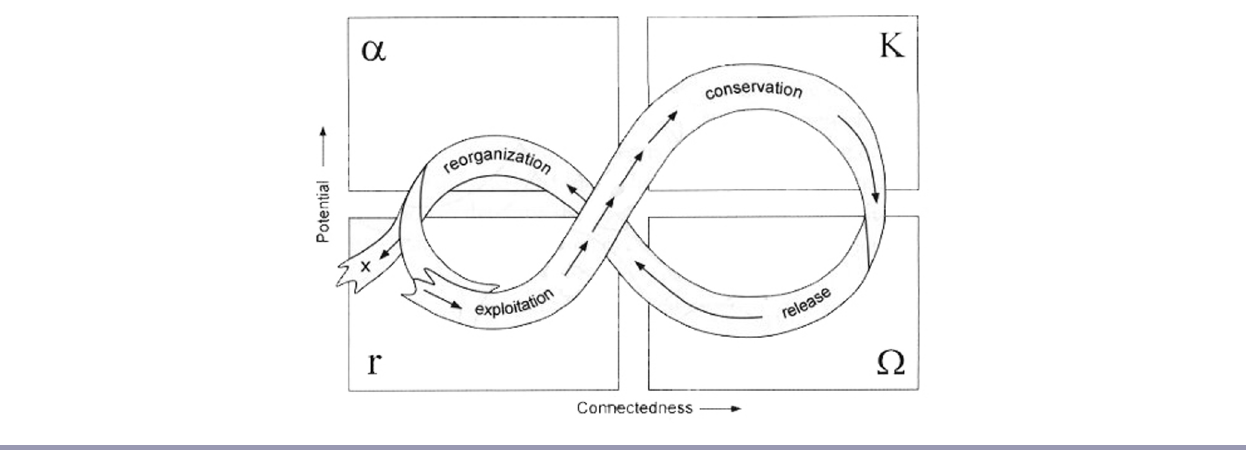
Fig. 1 . The adaptive cycle. A representation of the four ecosystem functions (r, k, omega, alpha) and the flow of events among them. The arrows show the speed of the cycle where short, closely spaced arrows indicate a slowly changing state and long arrows indicate a rapidly changing state. The cycle reflects changes in two properties: (1) Y axis—the potential that is inherent in the accumulated resources of biomass and nutrients; (2) X axis—the degree of connectedness among controlling variables. Low connectedness is associated with diffuse elements loosely connected to each other whose behavior is dominated by outward relations and affected by outside variability. High connectedness is associated with aggregated elements whose behavior is dominated by inward relations among elements of the aggregates, relations that control or mediate the influence of external variability. The exit from the cycle indicated at the left of the Figure suggests where the potential can leak away or where a change of state into a less productive and organized system is likely. From Panarchy: Understanding Transformations